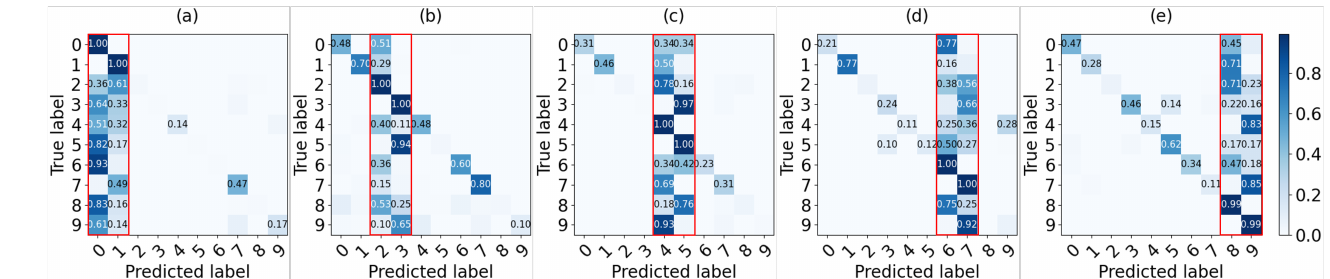
Figure 7. Confusion matrix of the G 4 global model added by a local model of each shard: ( a ) shard #1 with data 0–1, ( b ) shard #2 with data 2–3, ( c ) shard #3 with data 4–5, ( d ) shard #4 with data 6–7, ( e ) shard #5 with data